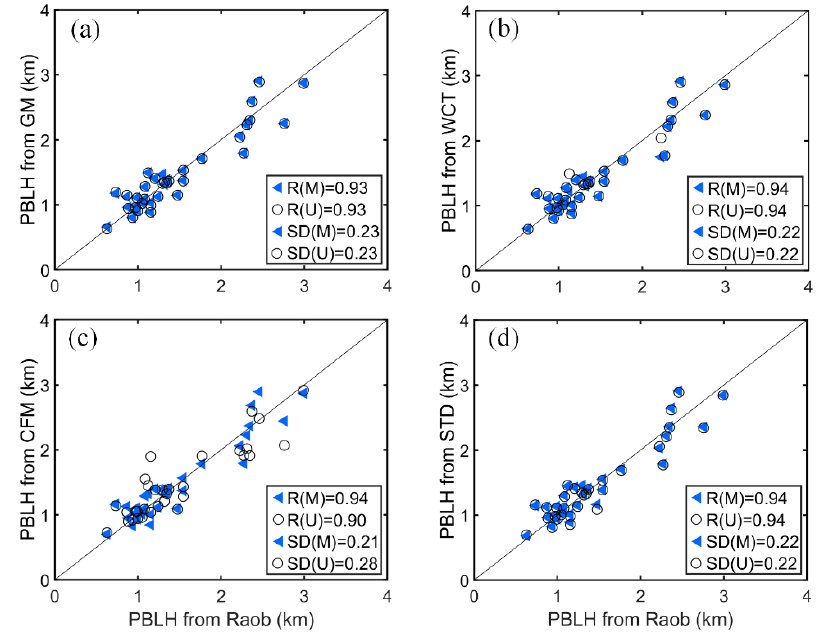
Figure 6. Comparison between radiosonde-determined (horizontal coordinate) and lidar measurement (vertical coordinate) of PBLH by ( a ) the gradient method (GM), ( b ) the wavelet covariance transform method (WCT), ( c ) the curve fitting method (CFM) and ( d ) the standard deviation method (STD) on 32 cases in single aerosol layer situations. The blue triangles and the black circles represent the comparison results with MLHI-RR and without limiter, respectively. The correlation coefficients are represented by R and standard deviations are represented by SD. The black solid line is the 1:1 line. M stands for MLHI-RR and U stands for unlimited.